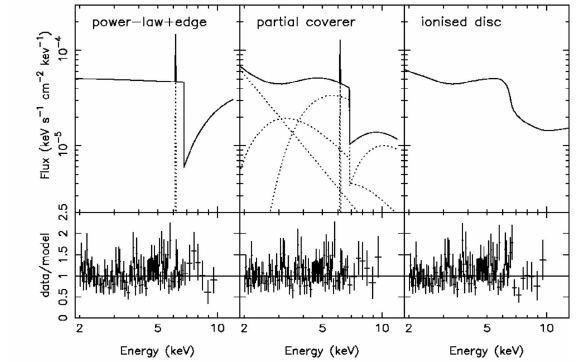
Figure 3: Sharp spectral cut-off detected in 1H0707- 495. A power-law plus absorption edge model, a partial covering model and an ionized reflection disk model are shown with their corresponding